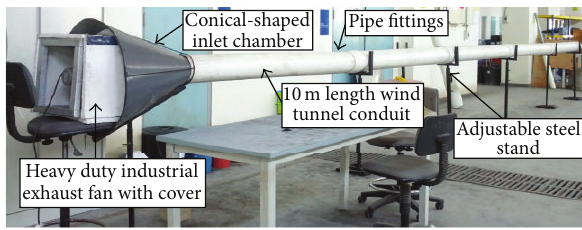
Figure 2: Side view of the wind tunnel production system setup.